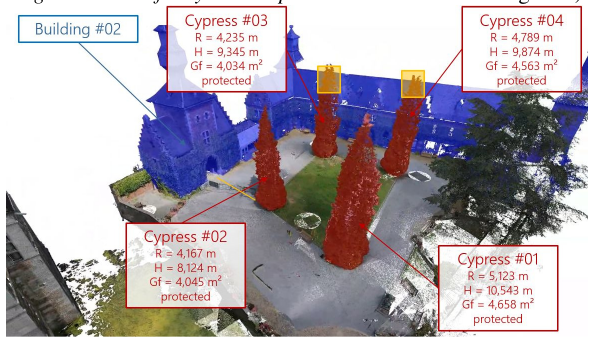
Figure 6 Example of a point cloud spatio-semantic